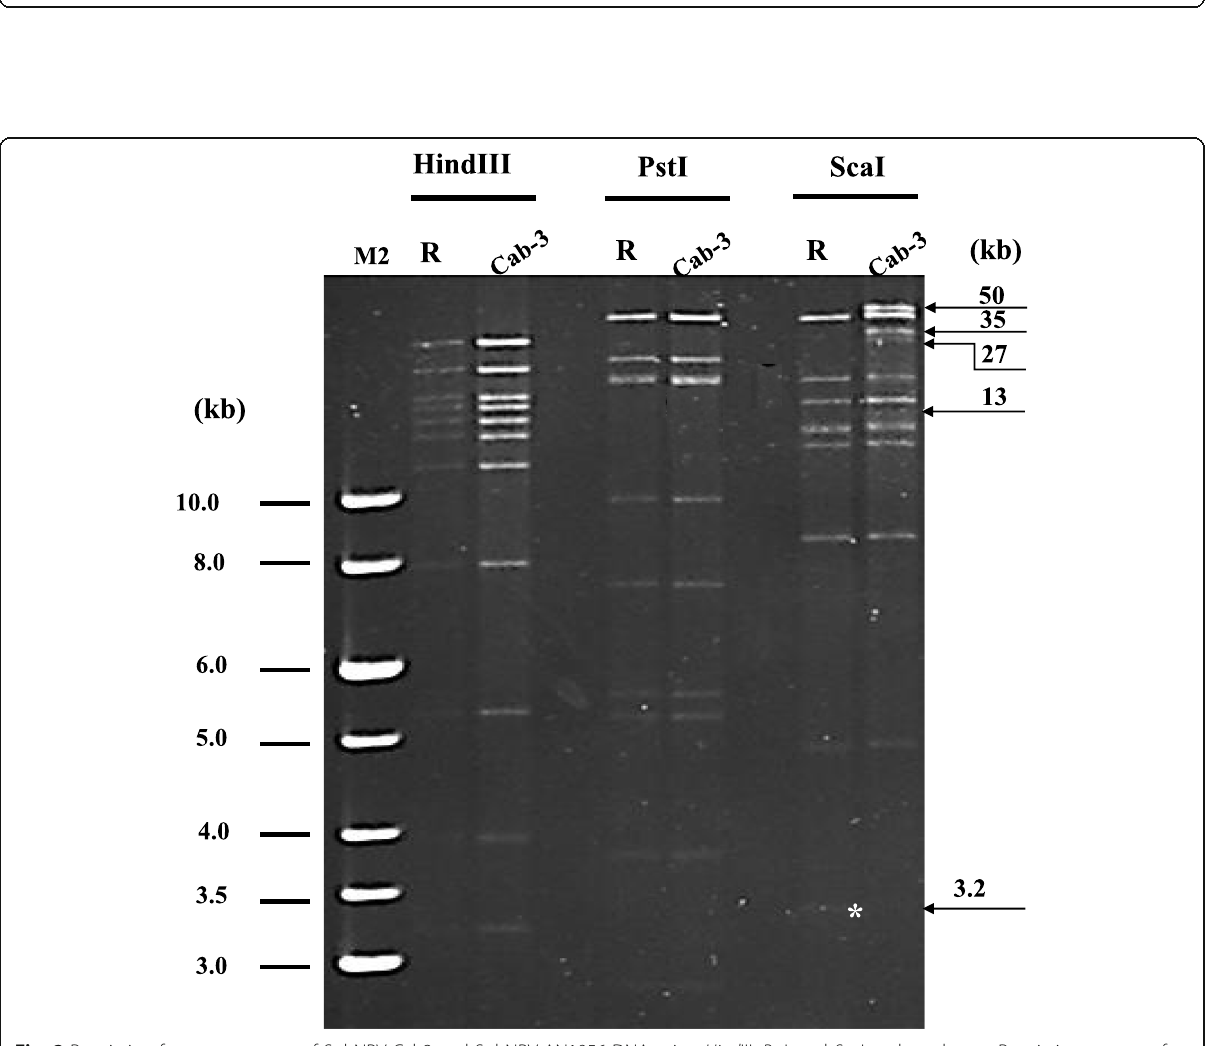
Fig. 2 Restriction fragment pattern of SpltNPV-Cab3 and SpltNPV-AN1956 DNA using Hind III, Pst I, and Sca I endonucleases. Restriction pattern of both SpliMNPV-Cab3 (Cab-3) and SpliMNPV-AN1956 (R). M1 represents lambda Hind III ladder. M2 represents 1kb DNA ladder. Fragments are indicated by kilo base